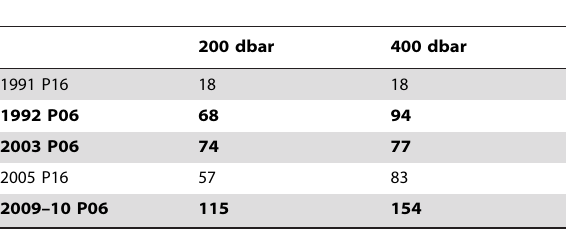
Table 1. Number of samples in study region.